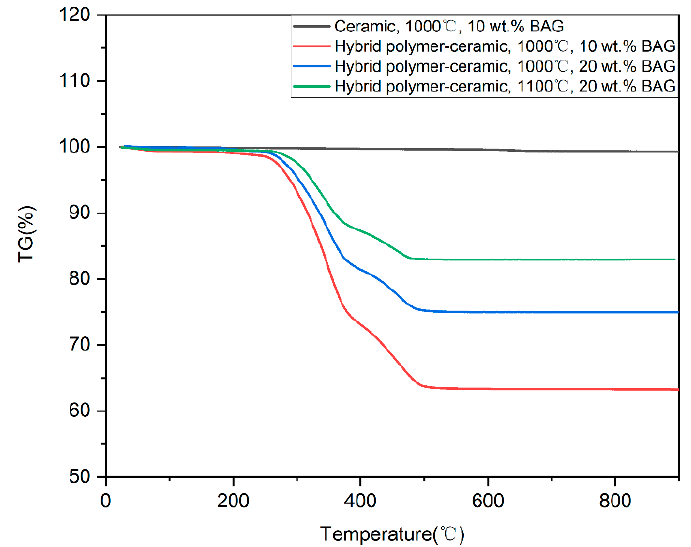
Figure 6. TG curves of HA/BAG ceramic and hybrid polymer–ceramic materials.